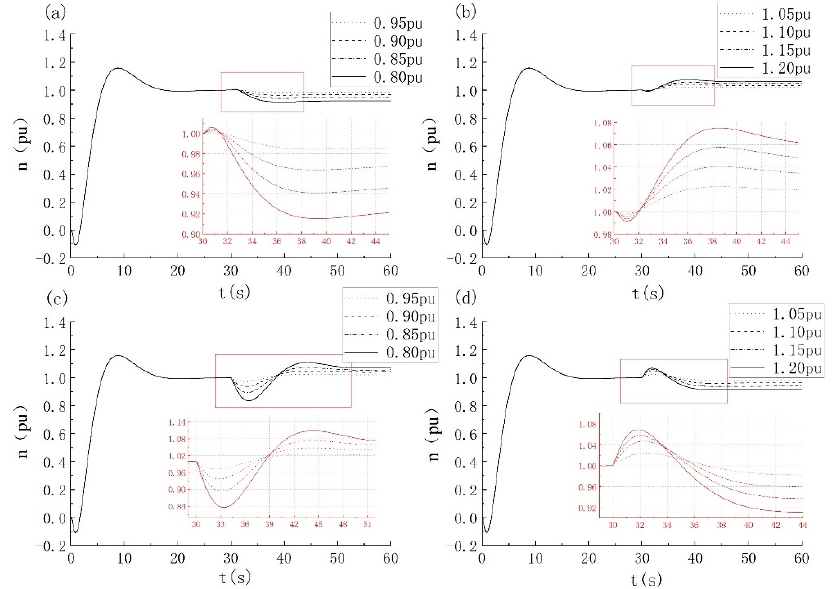
Figure 13. Load dynamic response curves: ( a , b ) the response curves of power command; ( c , d ) the response curves of head variation.